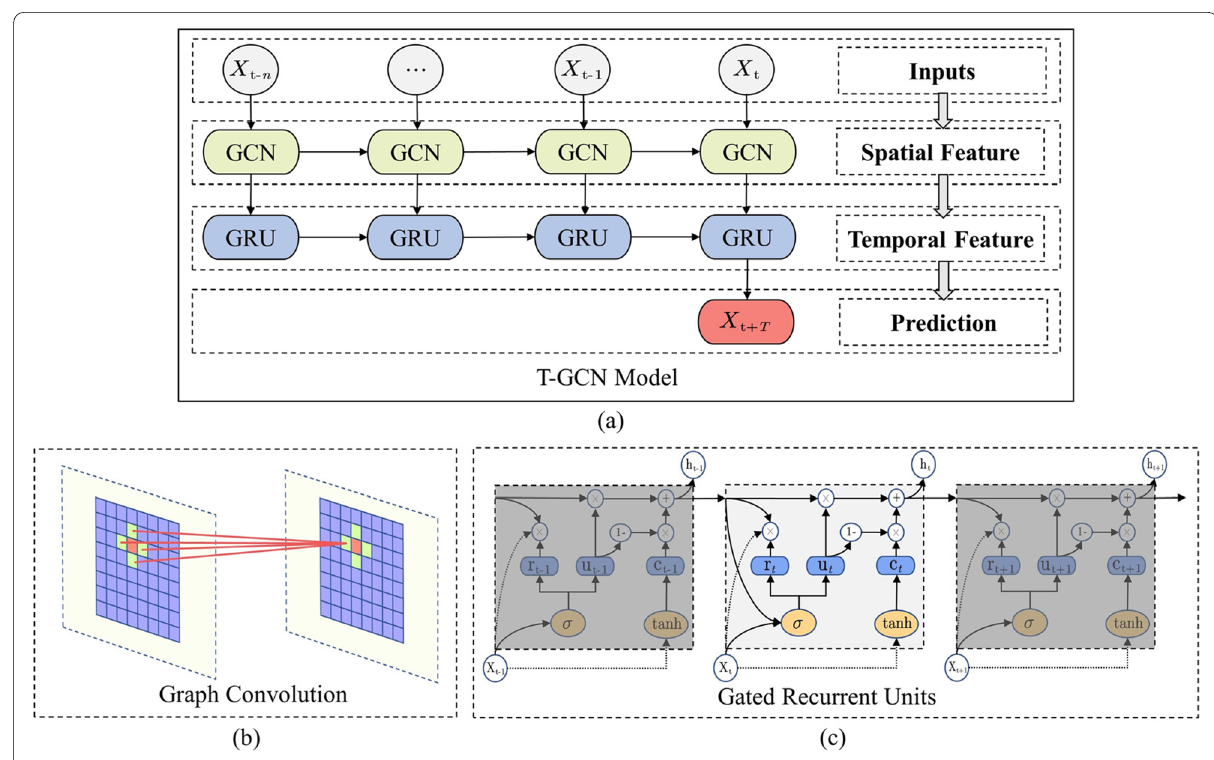
Fig. 1 a Internal structure of spatiotemporal prediction. b Spatial feature is obtained by obtaining the topological relationship between the red grid location and the surrounding green grids. c Temporal feature is obtained by obtaining the grid location status at time t and taking the hidden status at time t –1 and the current location information as